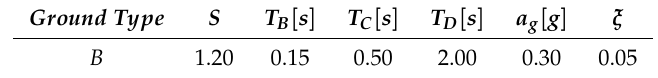
Table 1. Values of the parameters describing the Type 1 elastic response spectrum as defined in